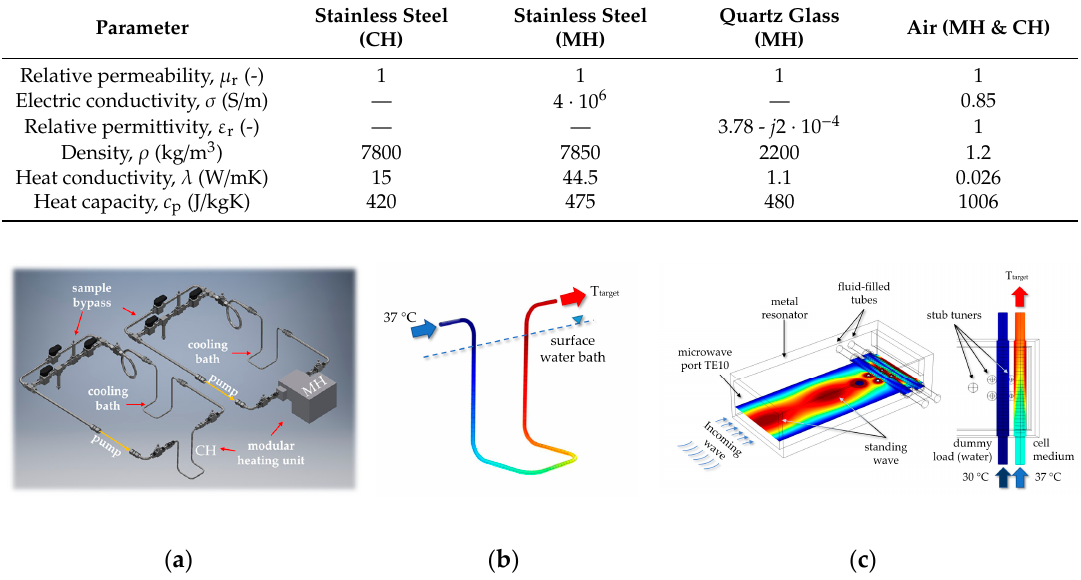
Table 3. Temperature-invariant material properties necessary for the simulation of the microwave (MH) and warm-water bath (CH) models (see Figure 16).